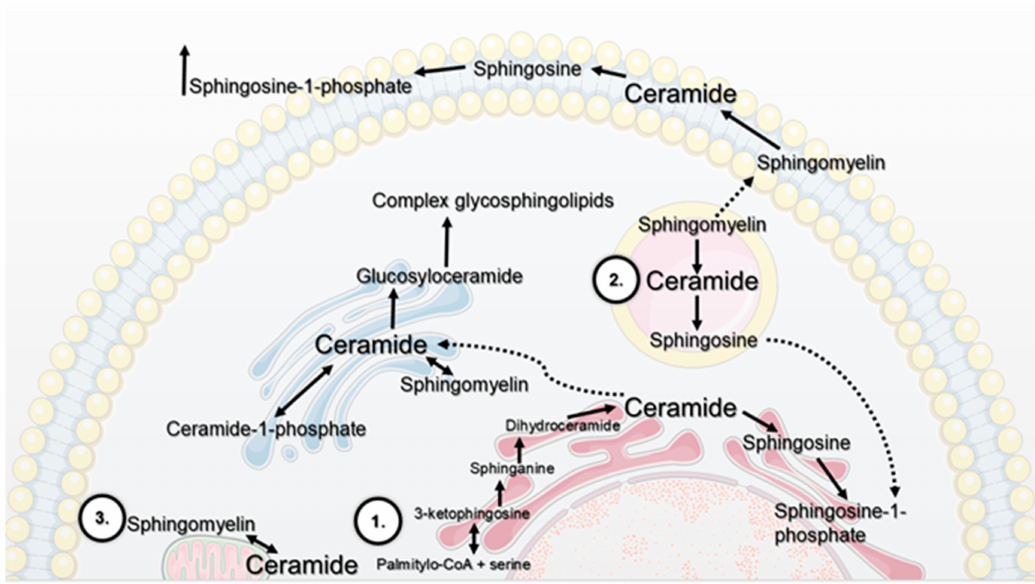
Figure 1. Key pathways of sphingolipid metabolism. De novo synthesis (1) of ceramide occurs mainly on the outer membrane. Ketosphinganine is formed as a result of the condensation of palmityl-CoA and serine. In the next stage, 3-ketosphinganine is rapidly converted to sphinganine. A fatty acid residue is attached to the sphinganine molecule, resulting in the formation of dihydroceramide. The final stage of de novo ceramide synthesis is desaturation, consisting in the formation of a double bond between carbons 4 and 5 in a dihydroceramide molecule. Then, ceramide is transported to the Golgi apparatus and metabolised to other sphingolipid groups. In lysosomes, the synthesis of ceramide from sphingosine under the influence of ceramide synthase is called the salvage pathway (2), where complex sphingolipids are digested to sphingosine, which can be transported to various cellular compartments. Ceramide may also be synthesized in the mitochondria-associated membranes